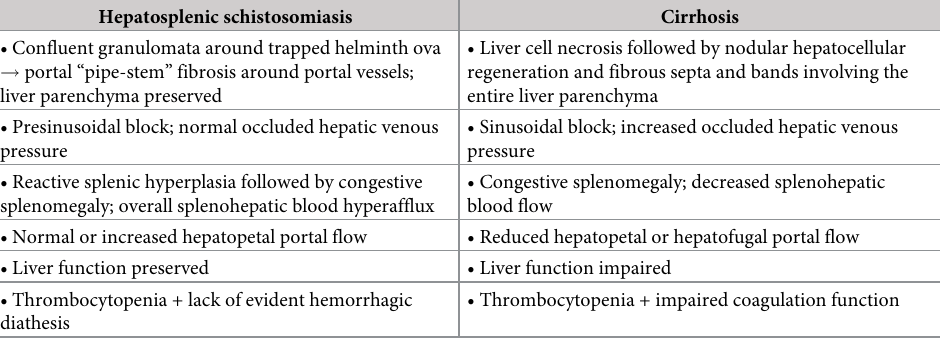
Table 1. Summary of the main different features of hepatosplenic schistosomiasis and